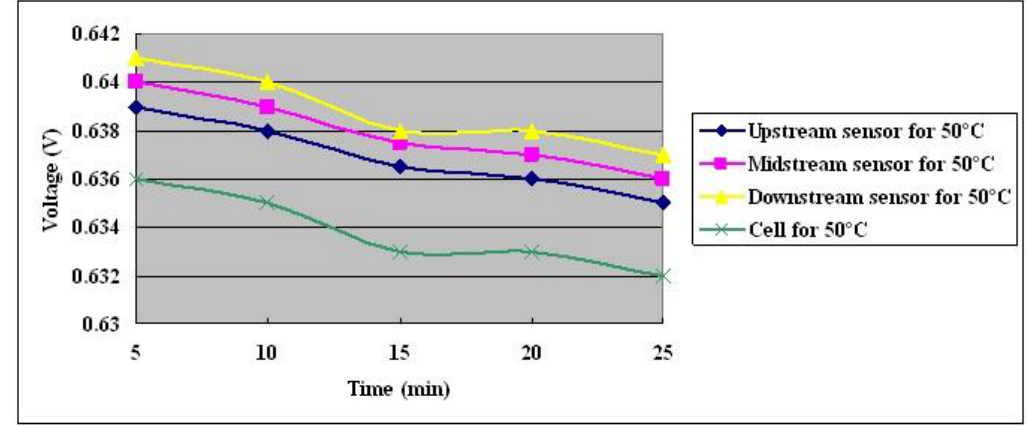
Figure 14. Voltage distributions at cell temperature of 50  C with constant output current of 25 A.